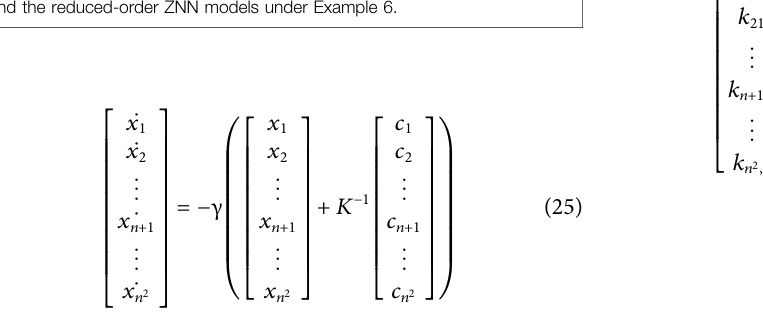
FIGURE 8 | Comparison of the convergence between the original-order and the reduced-order ZNN models under Example 6.